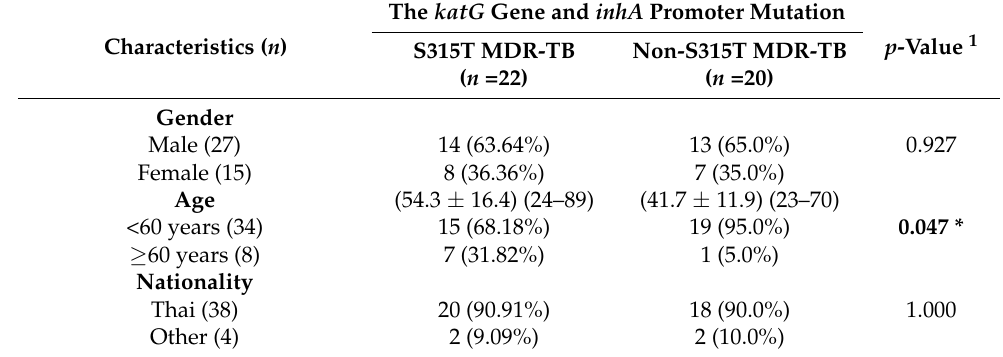
Table 5. Demographics and clinical characteristics of MDR-TB patients with different katG gene and inhA promoter mutations (S315T MDR-TB vs. non-S315T